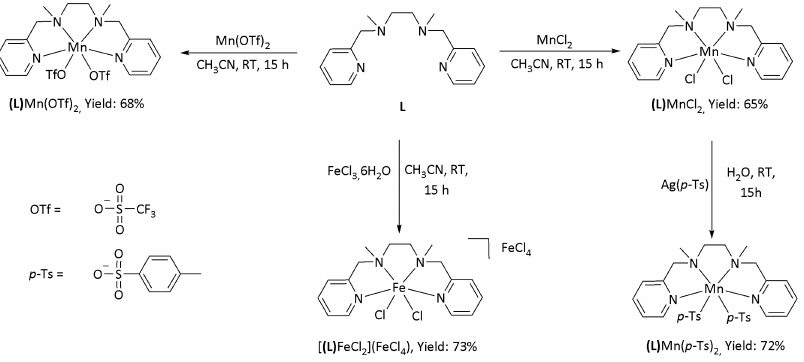
Figure 1. Synthesis of metal complexes of L